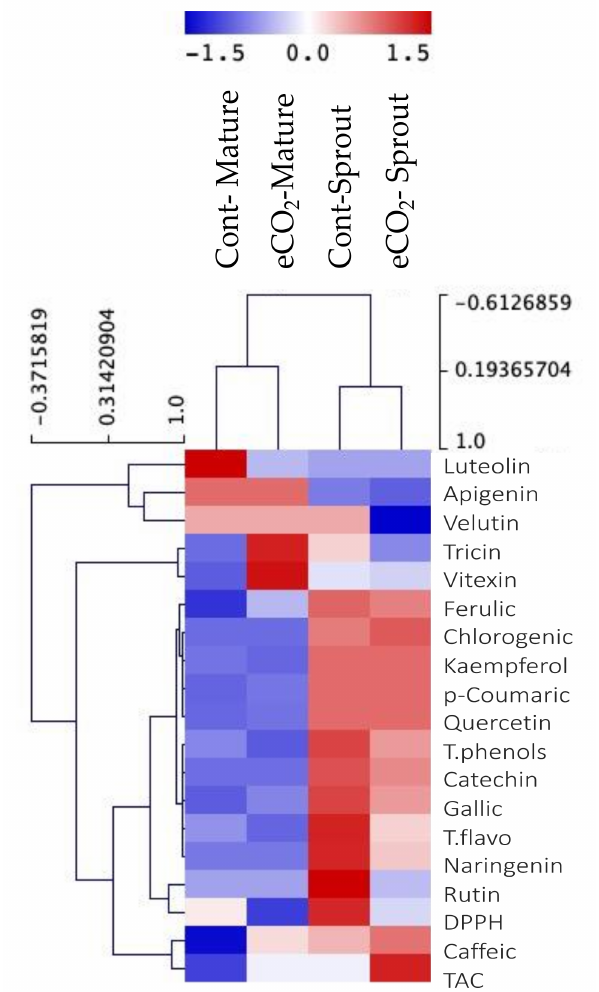
Figure 3. Hierarchical clustering analysis of phenolic compounds and antioxidant capacity of control and eCO 2 -treated caraway sprouts and mature plants. Data are represented by the means of at least 3